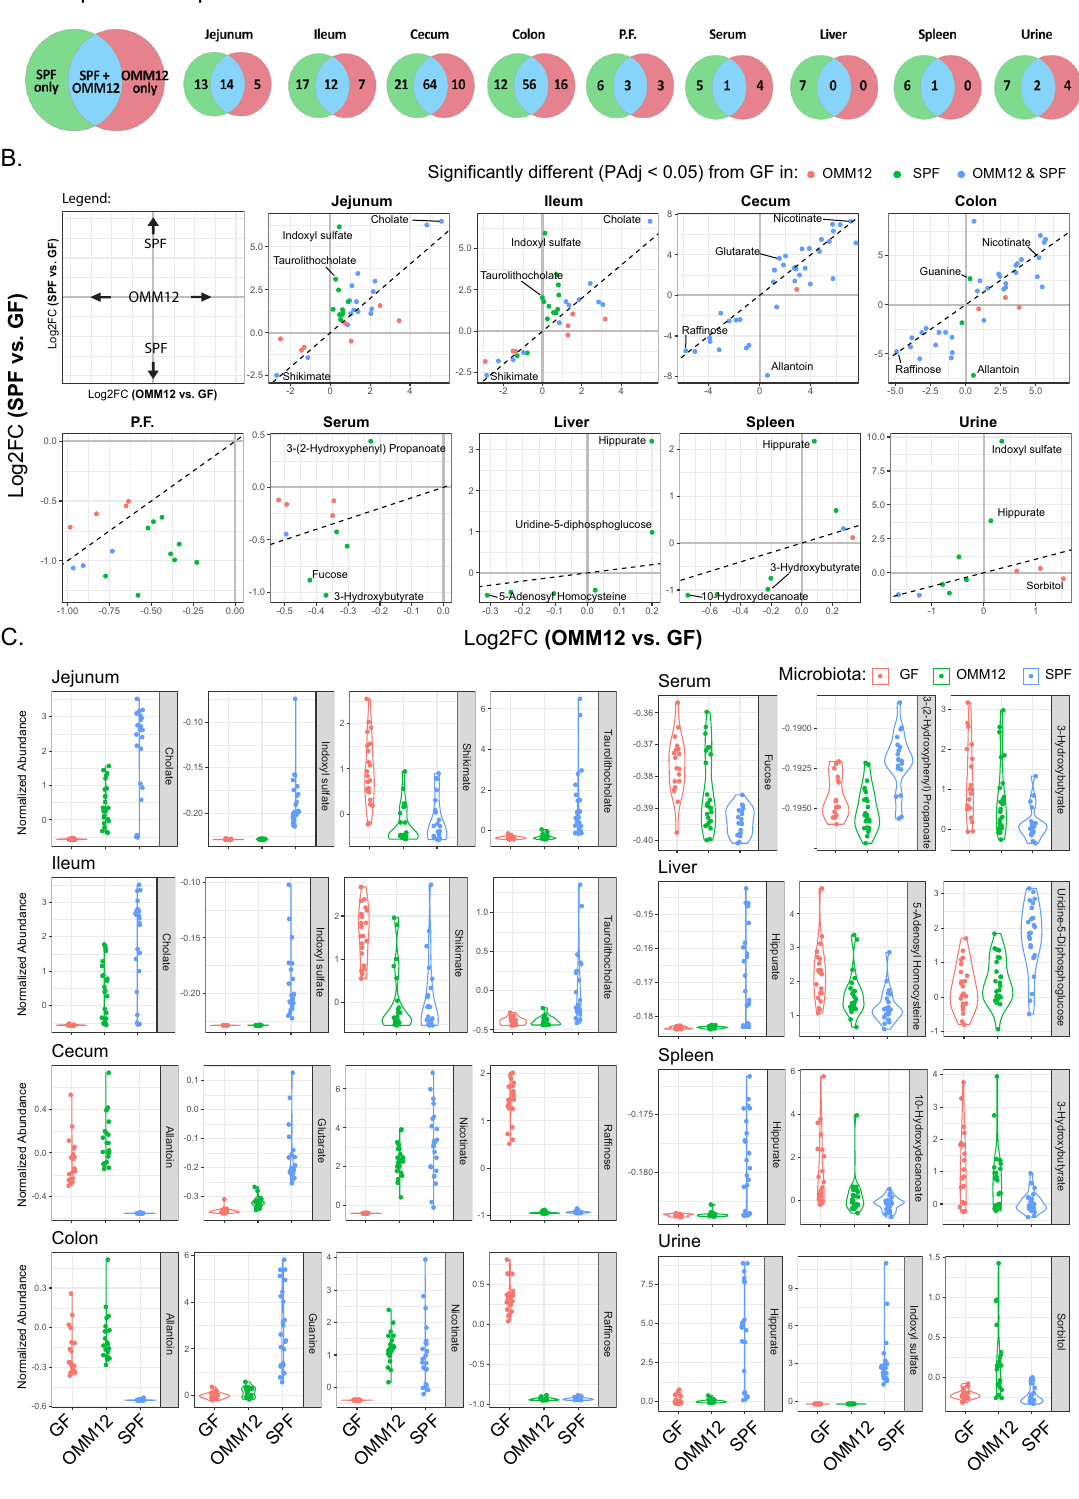
Fig. 3 | Impact of microbial composition on metabolism. A Number of meta- bolites thatare differentially abundant (PAdj<0.05) inOMM12 vs.GF(red), SPF vs. GF(green)andOMM12&SPFvs.GF(blue)ineachsamplesite. B Biplotshowingthe Log2FC in SPF vs. GF and OMM12 vs. GF in metabolites that were signi fi cantly different (PAdj <0.05) from GF in either colonization (red dots = OMM12, green